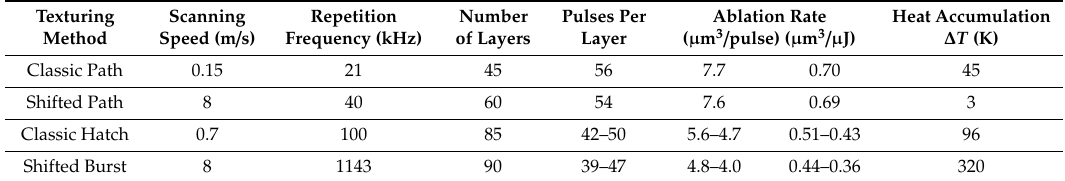
Figure 9. Comparison of the 3D profiles of the dimples produced by di ff erent methods (scanning strategies) at their highest allowed scanning speeds. Images are taken from di ff erent places on the sample: L—left, C—center, R—right.